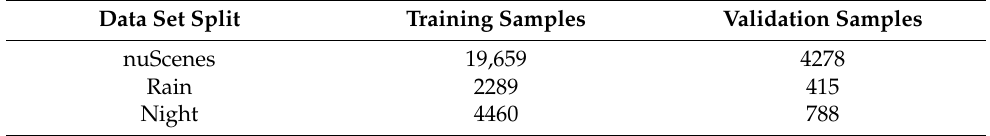
Table 1. Training and validation splits for different environment conditions. The table only considers samples in which at least one car is present in the field of view of the front